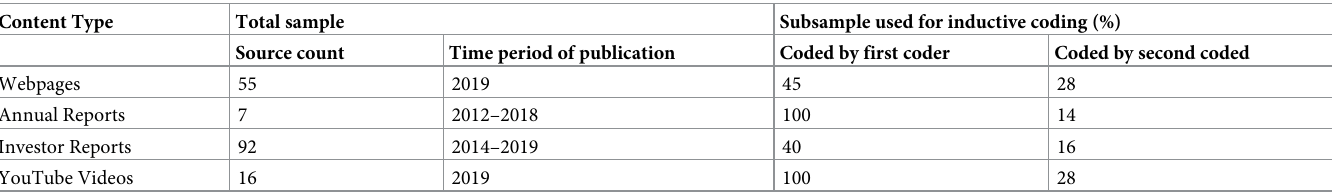
Table 2. Data capture and coding